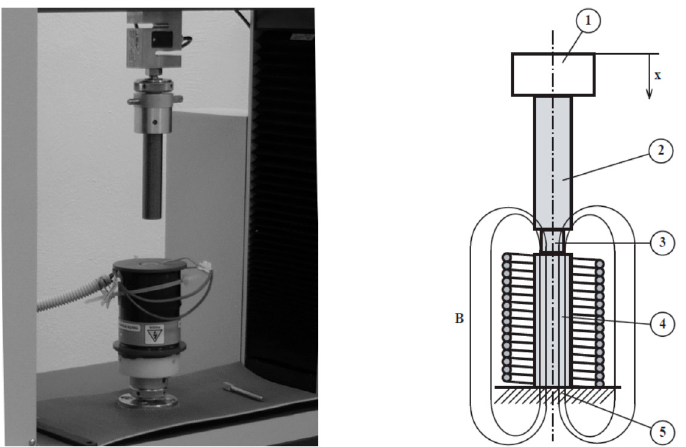
Figure 6. Static valve mode of operation using MRE on the top of the magnet and applying the loading force. Reprinted from [20], © 2016 with permission from Elsevier.